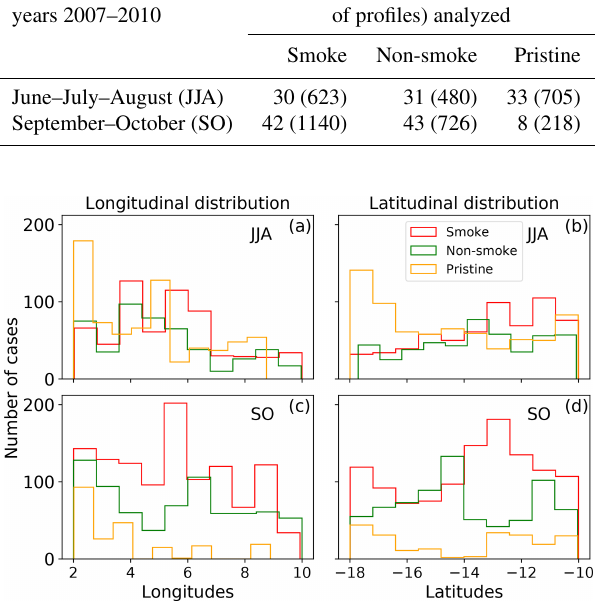
Figure 2. Longitudinal distributions (spanning latitudes from 10 to 18 ◦ S) and latitudinal distributions (spanning longitudes from 2 to 10 ◦ E) of the cases analyzed during June–July–August (JJA) (a, b) and September–October (SO) (c, d) during the period